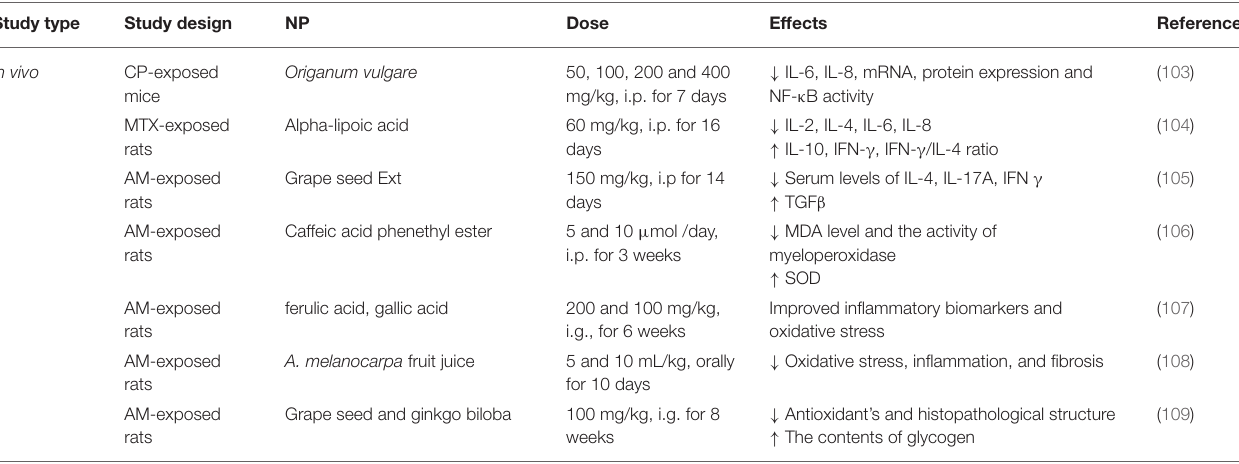
TABLE 7 | The effect of other noxious agents-induced lung